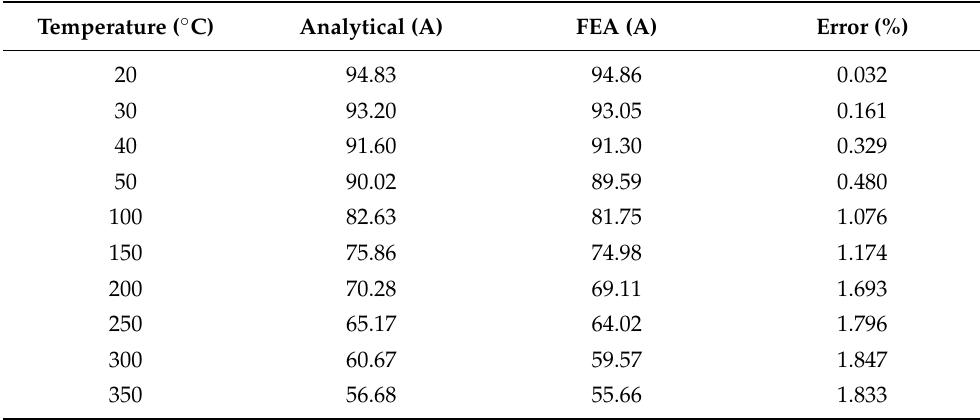
Table 3. Calculation of the inter-turn SC current under different temperatures.